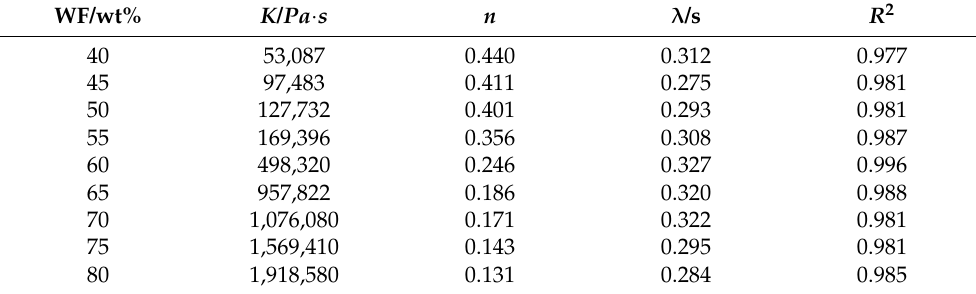
Table 2. Power law parameters of different WPC of the content of wood